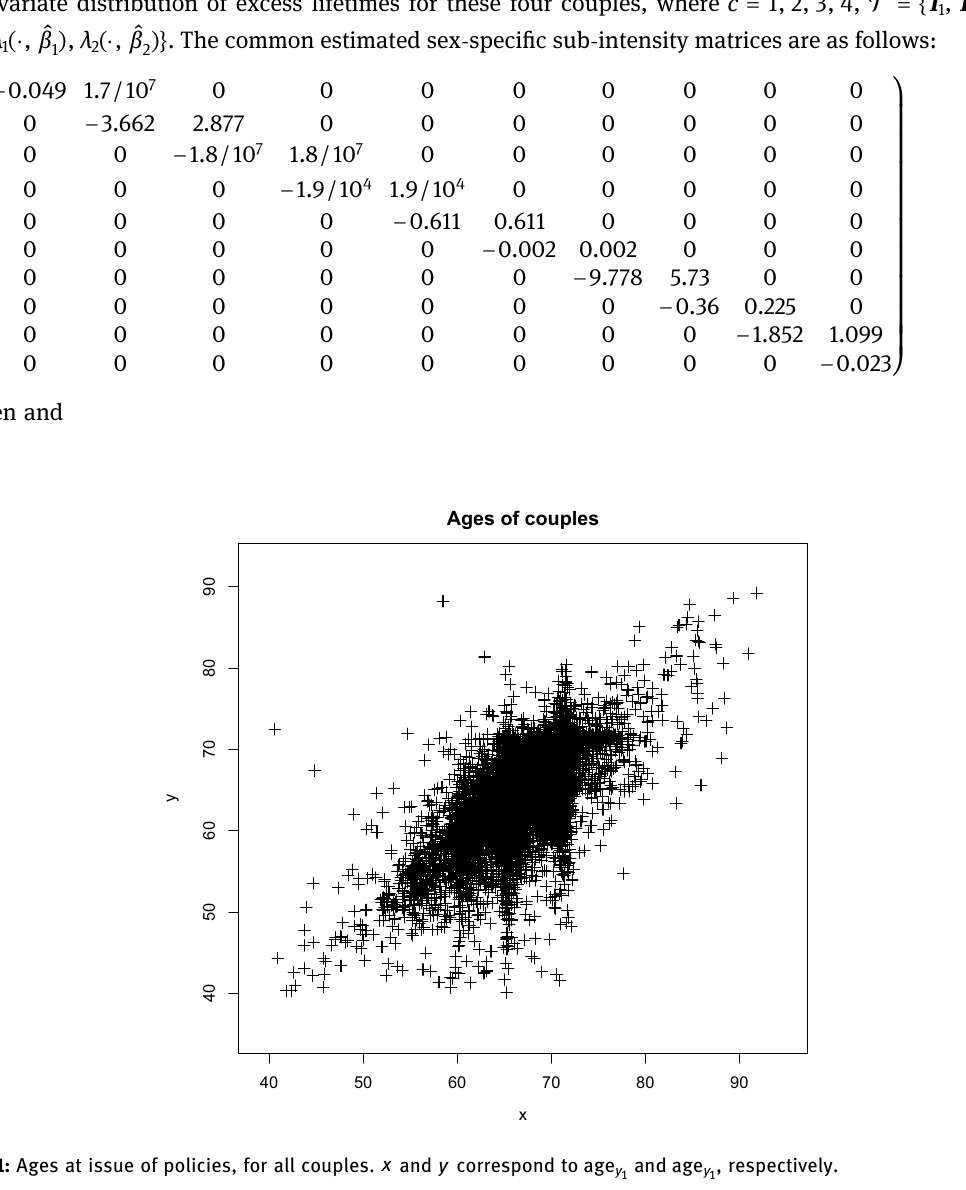
Figure 1: Ages at issue of policies, for all couples. x and y correspond to age y